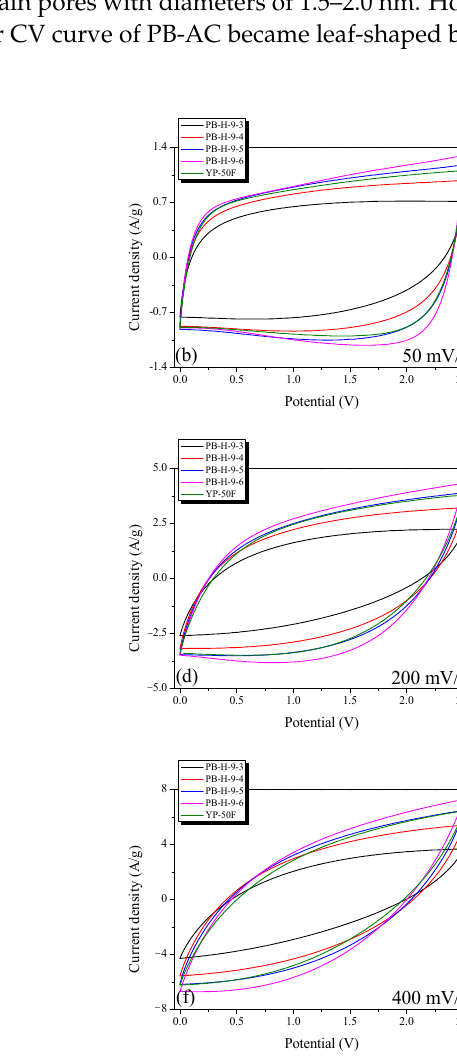
Figure 8. Cycle voltammograms of the bamboo-derived activated carbon samples at various scan rates: ( a ) 5, ( b ) 50, ( c ) 100, ( d ) 200, ( e ) 300, and ( f ) 400 mV/s. Next, Nyquist plots were prepared to analyze the impedance data obtained for the EDLCs. In a typical Nyquist plot, a semicircle is observed in the high-frequency region and a Warburg line (slope of approximately 45°) is observed in the low-frequency region [40]. The semicircle portion in the Nyquist plot corresponds to the charge transfer process, with the diameter of the semicircle is proportional to the charge transfer resistance ( R CT ) [41]. The diffusion coefficient is calculated in the low-frequency region (Warburg imped- ance) [41]. The diffusion coefficient is related to the mobility of the diffusion ions and is proportional to the squared velocity of diffusing ions, which means that there is faster diffusion of ions with a higher diffusion coefficient [41]. Figure 9 shows the Nyquist plots of the EDLCs prepared containing the PB-AC sam- ples. The data about Nyquist plots were listed in Table 2. As shown in the Figure 8, as the activation time increased, the size of the semicircle decreased until an activation time of 50 min, after which the semicircle size increased. The diameter of the semicircle can be attributed to the interfacial resistance of the electrode pores and the electrolyte. Thus, the interfacial resistance decreased because the pore diameter increased with an increase in activation time (20 to 50 min). On the other hand, the interfacial resistance of PB-H-9-6 increased because of the formation of oxygen functional groups caused by the oxidation of the crystal edges [42].